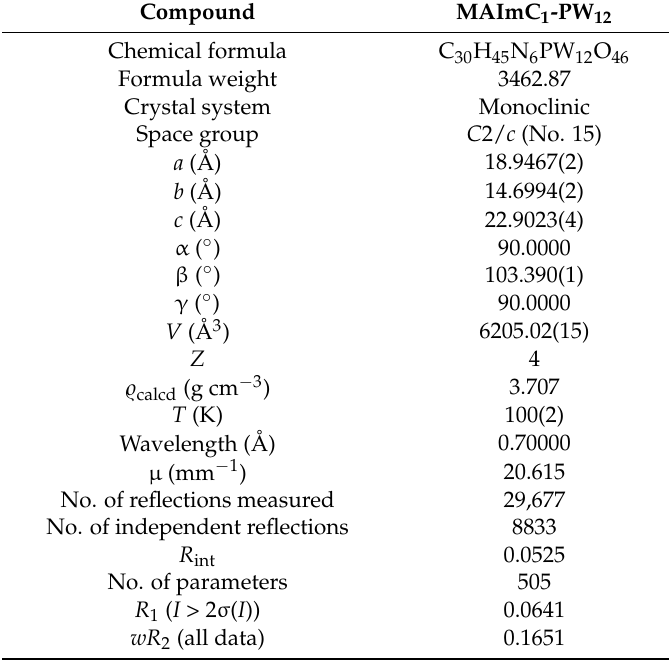
Table 1. Crystallographic data of the MAImC 1 -PW 12 hybrid